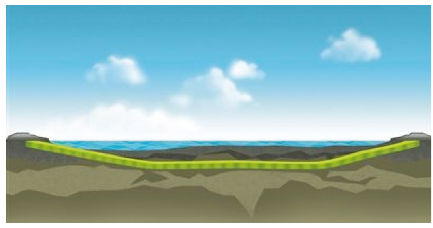
Figure 4: Immersed tunnel.